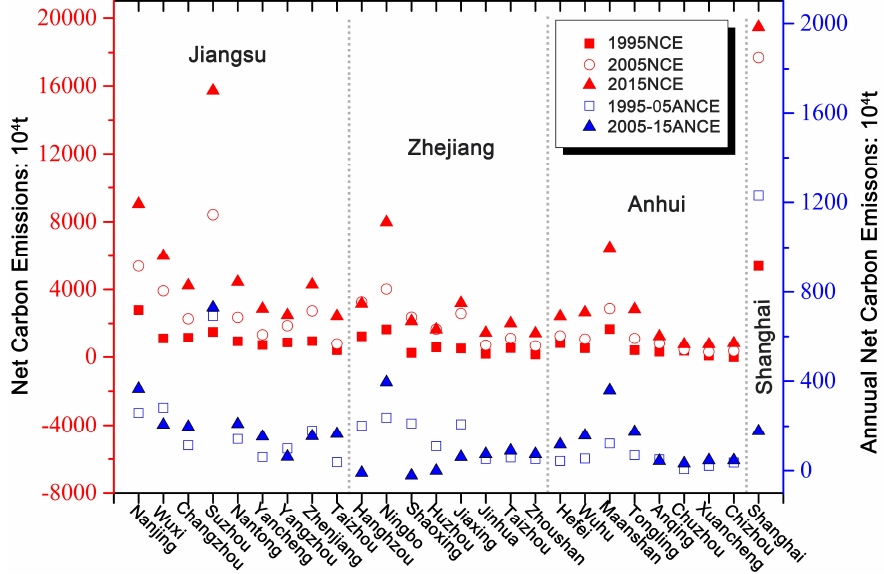
Figure 5. Land-use specific net carbon emissions (NCE) and annual net carbon emissions (ANCE) for the 26 YRDUA cities in 1995, 2005, and